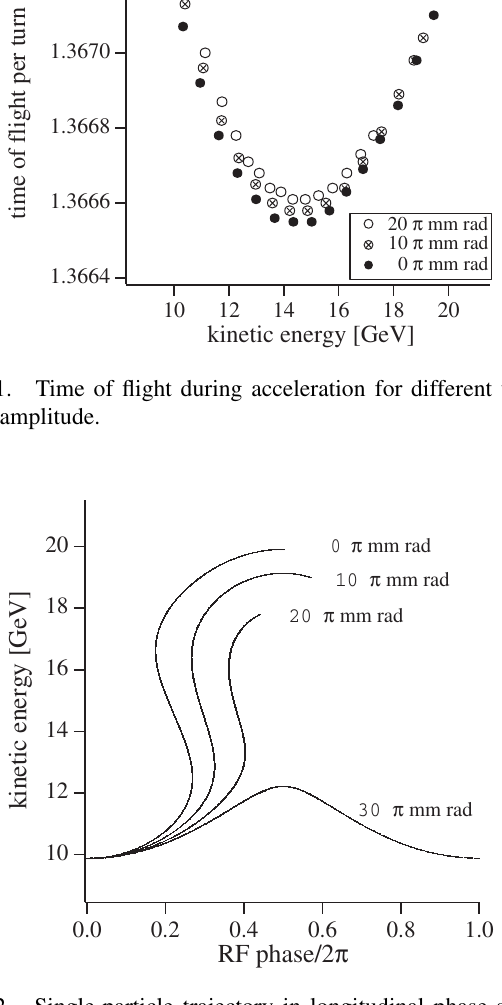
FIG. 2. Single-particle trajectory in longitudinal phase space. All particles start from the same point but with different trans- verse